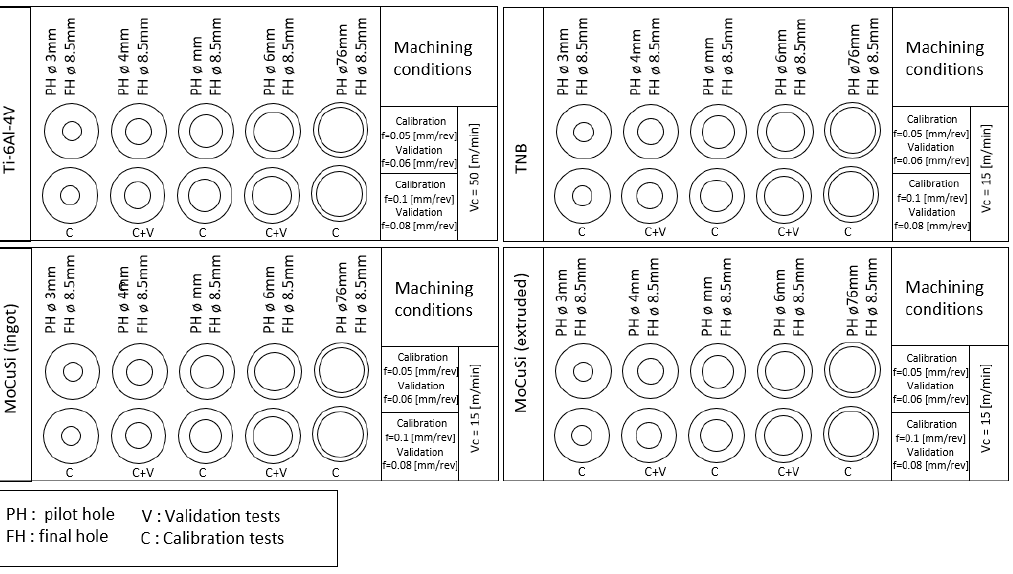
Figure 2. Experimental holes set–up.